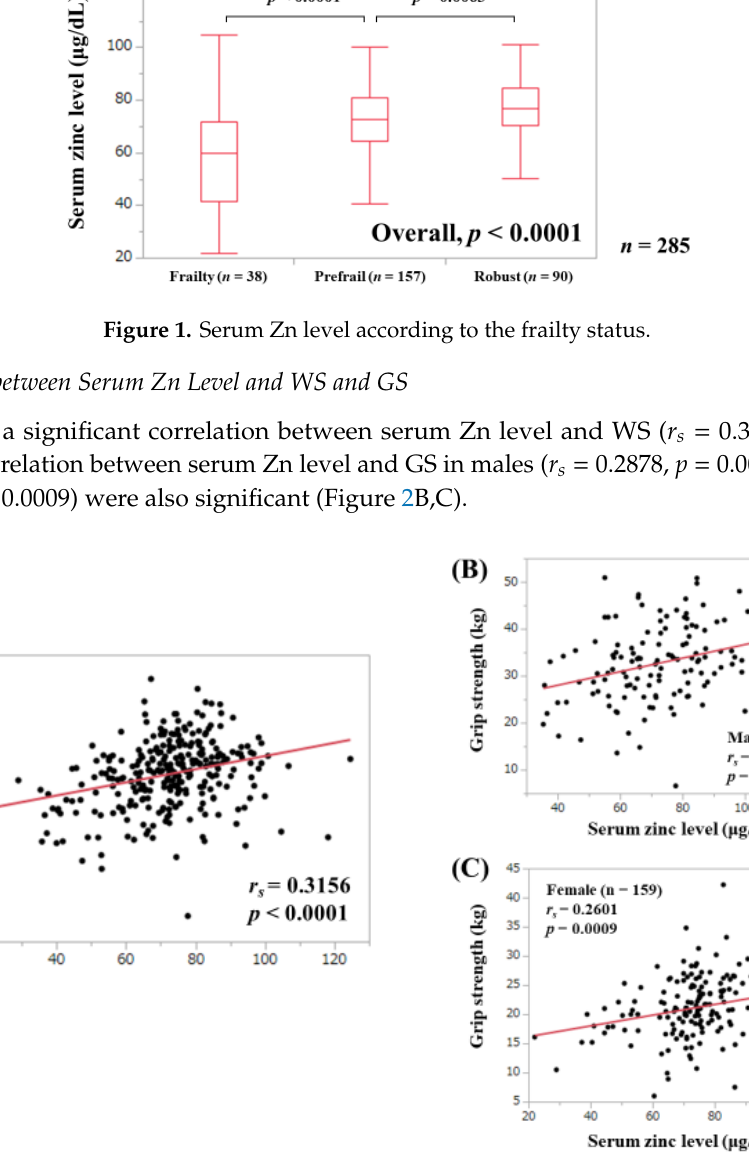
Figure 2. ( A ) Correlation between the serum Zn level and walking speed. ( B ) Correlation between the serum Zn level and grip strength in men. ( C ) Correlation between the serum Zn level and grip strength in women.